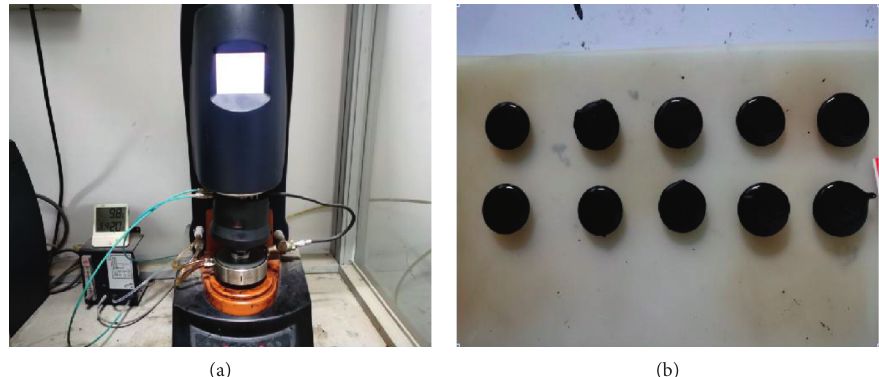
Figure 3: DSR test of high modulus asphalt: (a) DSR tester; (b) asphalt specimen.